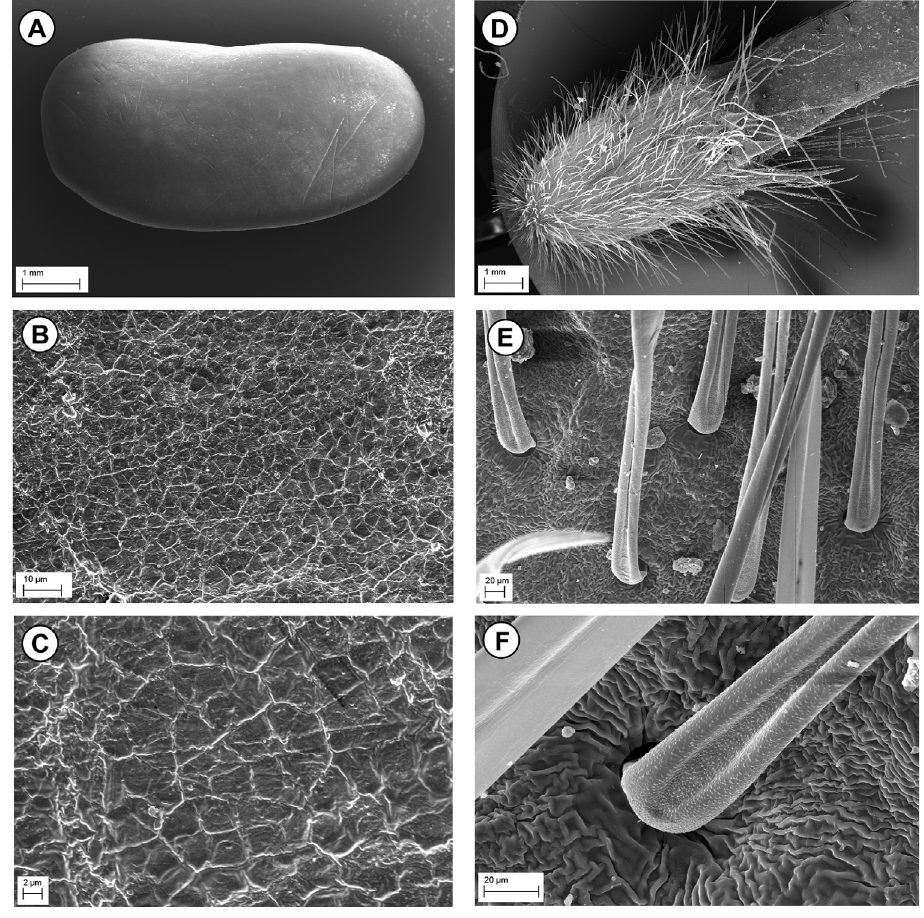
Figure 5. SEM micrographs of seed testa ( A–C ) and pod hairs ( D–F ) of Bituminaria antiatlantica from Mount Tachilla in Morocco. A Seed at low magnification (× 15) B Seed testa at medium magnification (× 1000) C Seed testa at high magnification (× 2500) D Pods at low magnification (× 10) E Pod hairs at medium magnification (× 250) F Pod hairs at high magnification (×